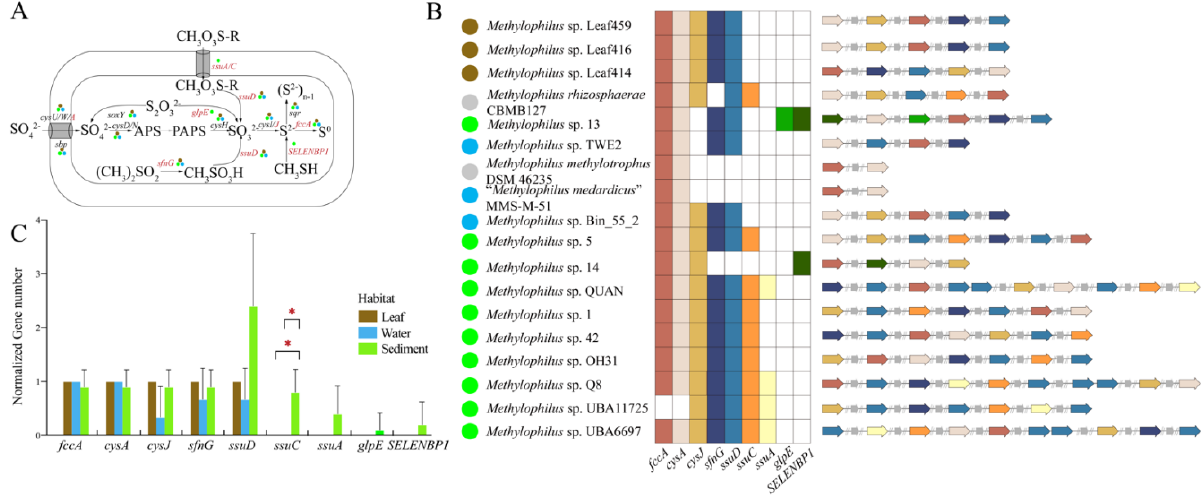
Figure 7. ( A ) Sulfur metabolic pathway. Each step of the reaction is tagged with the corresponding genes. Genes that are present in all genomes are highlighted in black, while those that are present in partial genomes are highlighted in red. ( B ) Distribution of partial sulfur metabolism genes in Methylophilus genomes. The colored boxes indicate that the gene is present in the genome, whereas the white box indicate that is absent. Functional gene clusters structural plot was performed according to the heatmap. The colored arrows correspond to the colored boxes. The grey arrows represent unknown genes. The solid circles with colors, blue, brown, green and grey, represent isolation sources, water, leaf, sediment and others, respectively. ( C ) Histogram constructed by computing the normalized number of partial sulfur metabolism genes involved in ( B ). Three box colors represented three environments. Significant differences in ssuC gene between leaf versus sediment and water versus sediment by one-way ANOVA. *: p < 0.05.